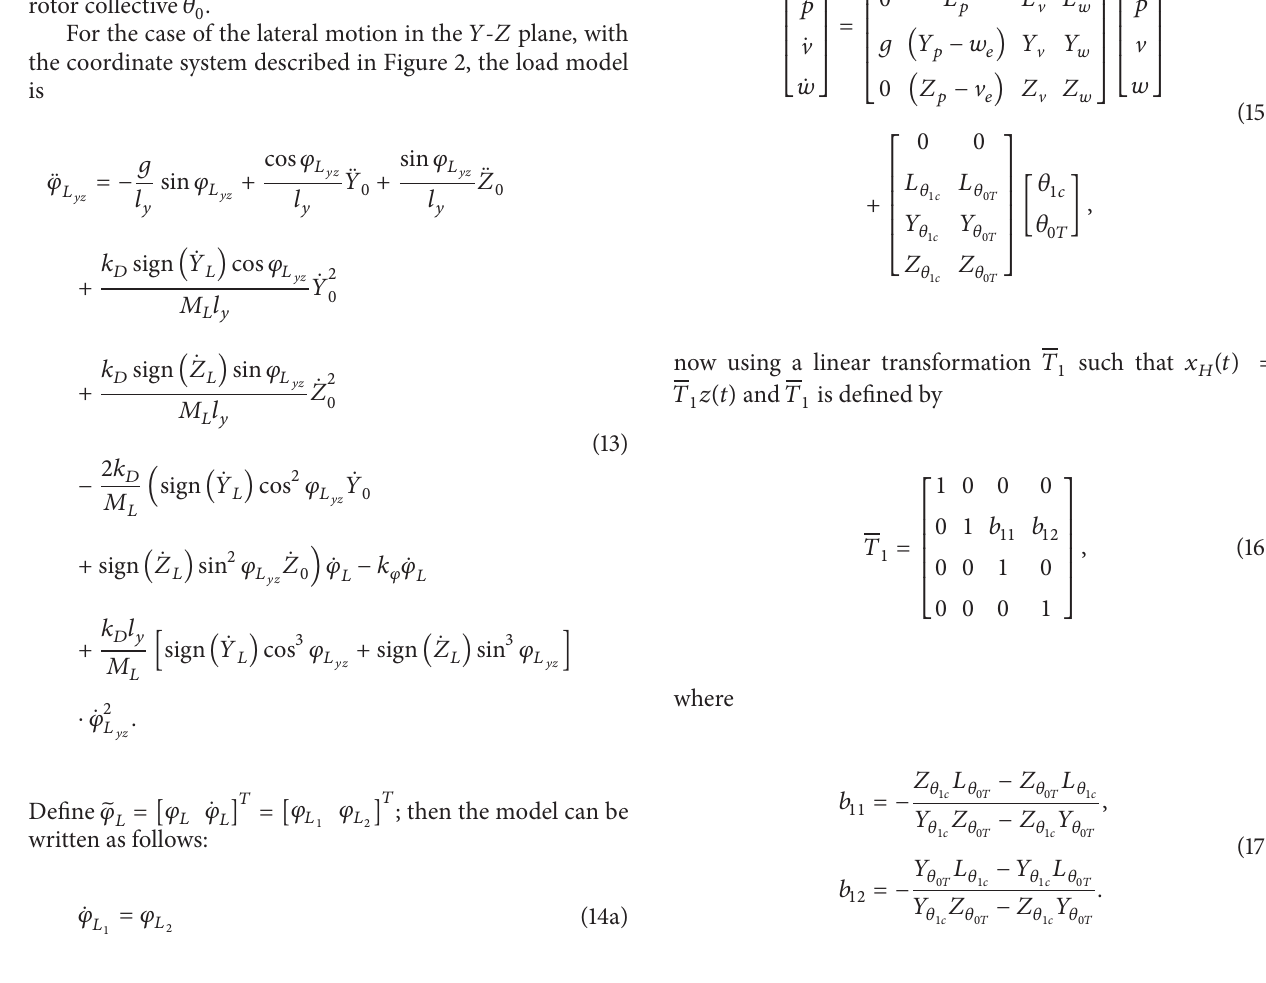
It is assumed that the longitudinal motion is primarily controlled by longitudinal cyclic commands (𝜃 1𝑠 ) and main rotor collective 𝜃 0